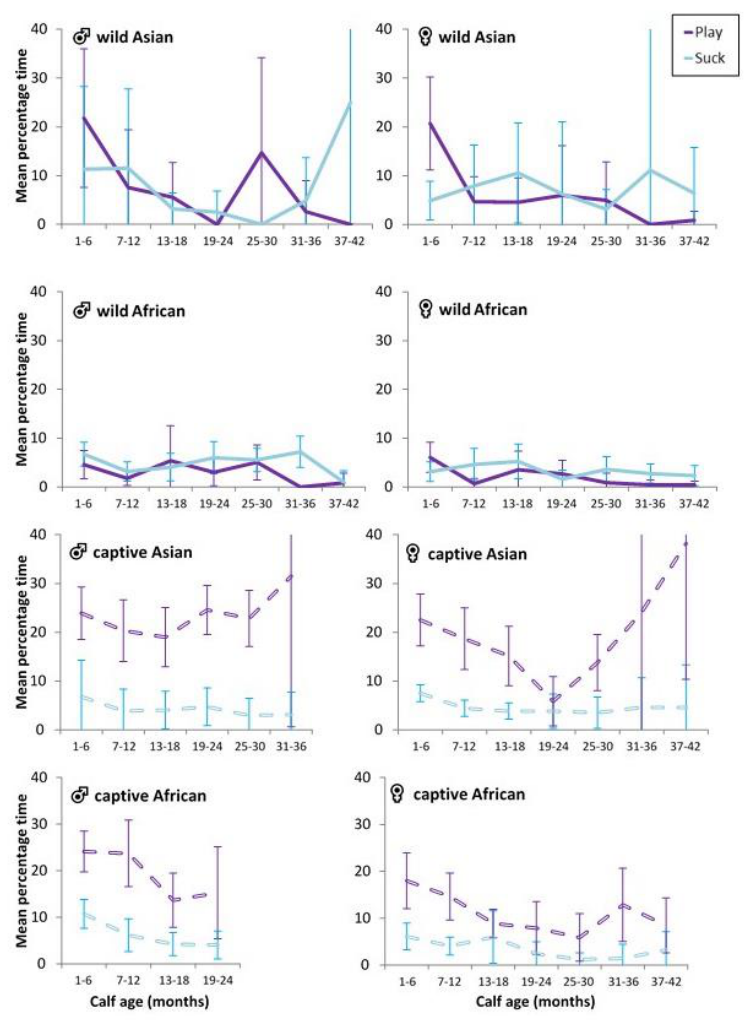
Figure 2. Mean percentage of observation time ( ± 95%CI) in play and suckling interactions by context and sex for calves from birth to 3.5 years.